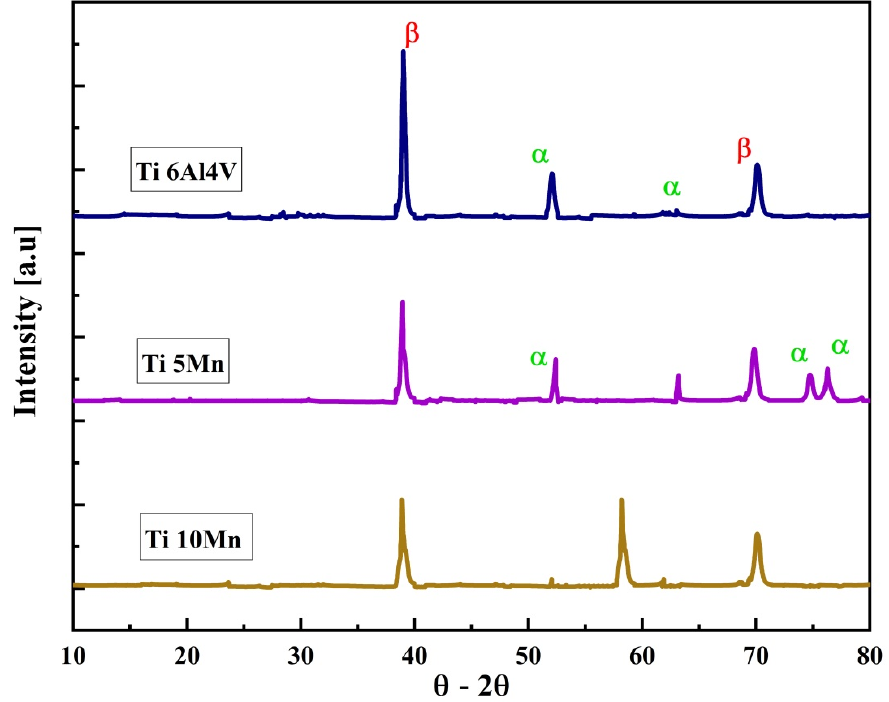
Figure 2. The XRD pattern of the titanium-based alloys. The pink line represents Ti5Mn, the brown line represents Ti10Mn, and the blue line represents Ti6Al4V.